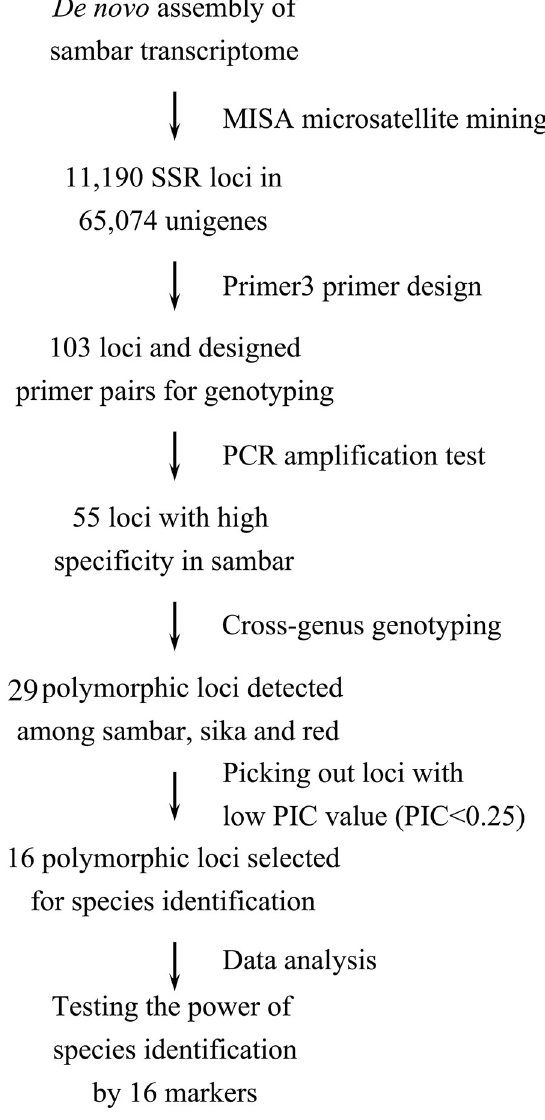
Fig 1. Flowchart of marker development for 16 cross-genus